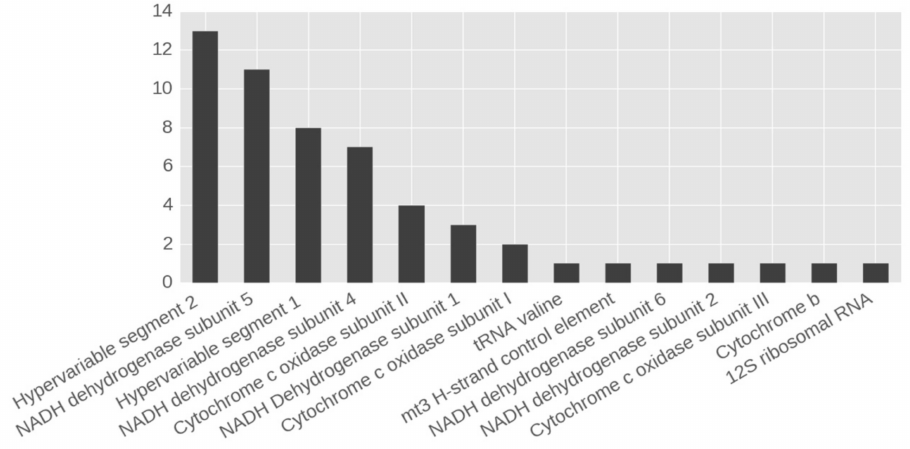
Figure 1. The number of heteroplasmic variants found in regions and genes of mitochondrial DNA (mtDNA).